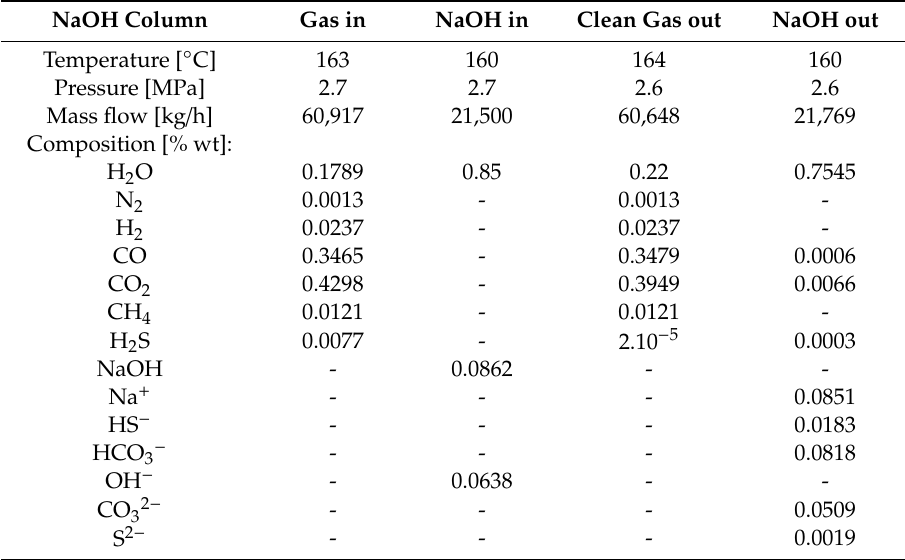
Table A3. Detailed NaOH column operation simulation